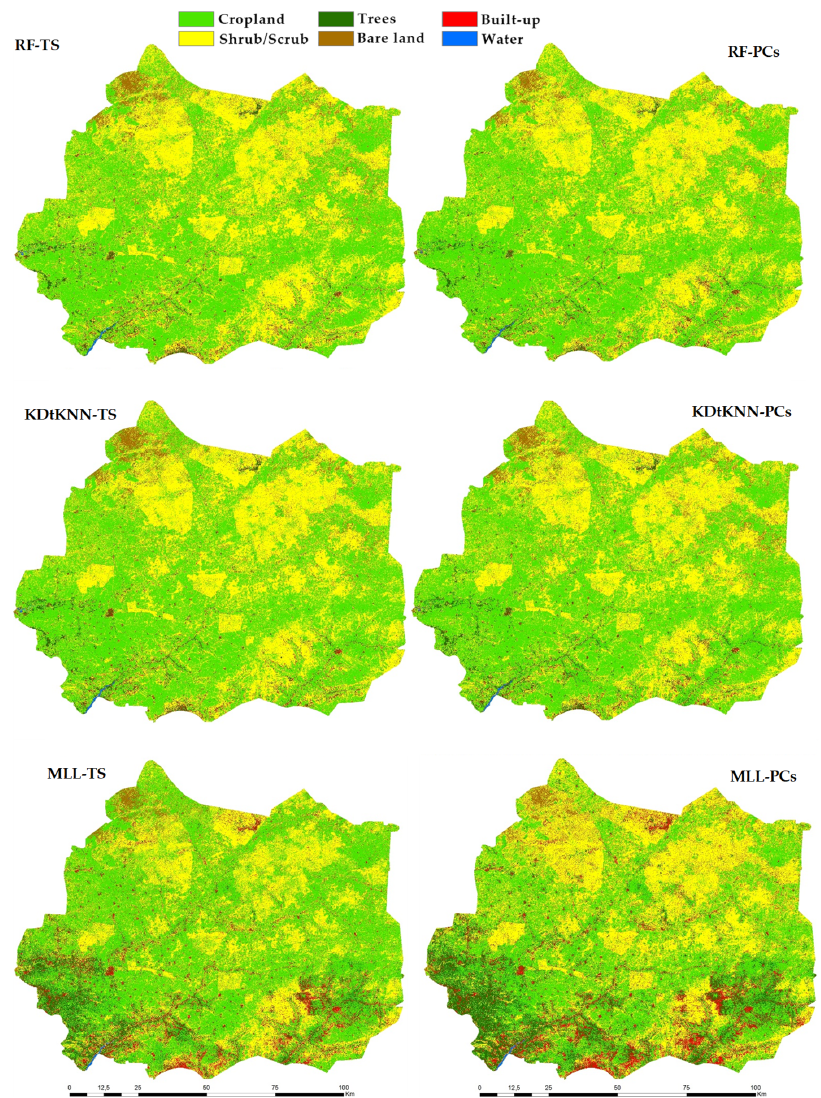
Figure 6. The best results for land cover maps of Kaffrine obtained from RF, KDtKNN, and MLL applied to the S-1 time-series (TS) data ( left ) and PCs ( right ). RF using 100 trees and 50 trees was the most accurate for PCs and time series, respectively, while KDtKNN using 15 neighbors was the most accurate for both feature inputs.